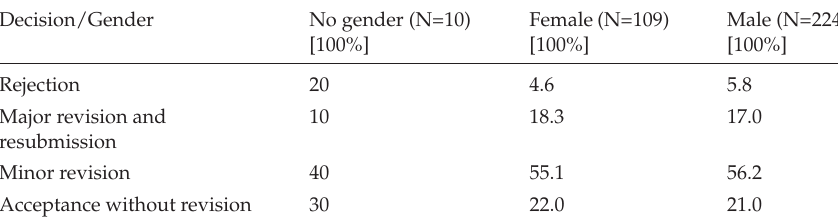
Table 5: Reviewers’ recommendations according to their gender of the reviewers